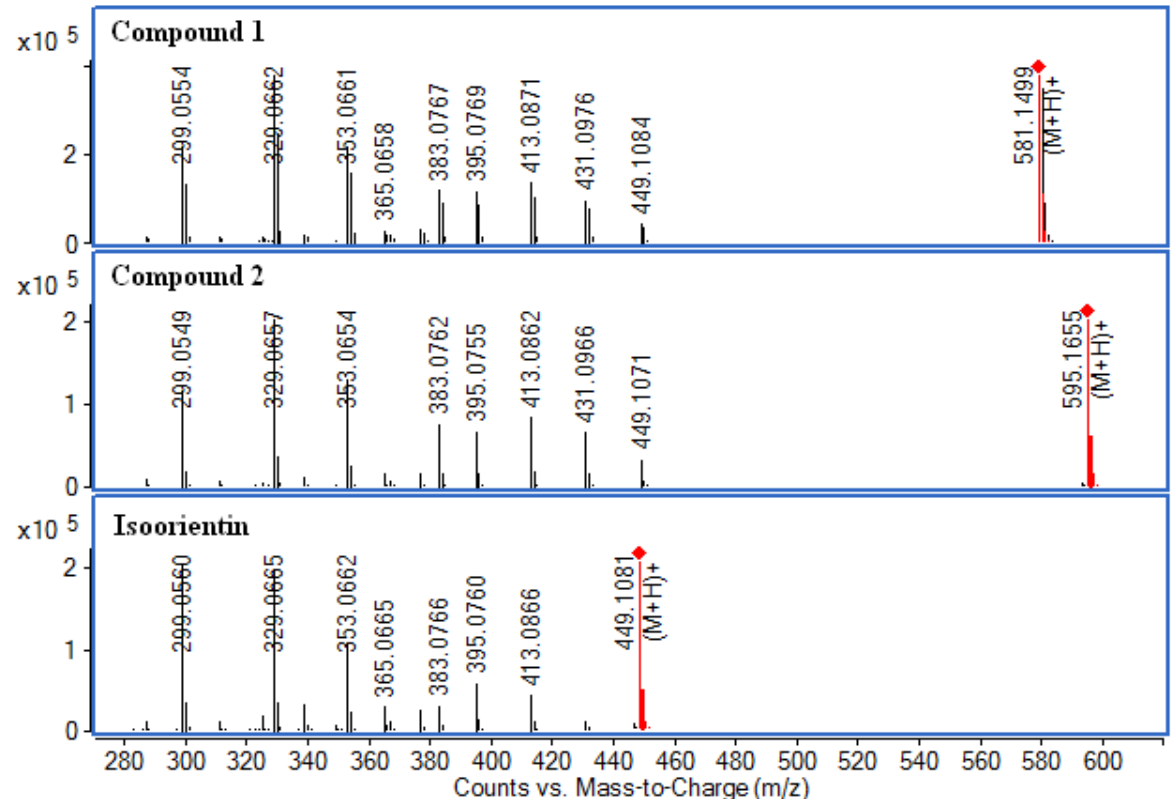
Figure 7. (+)ESI-MS/MS mass spectra of compounds 1 , 2 and